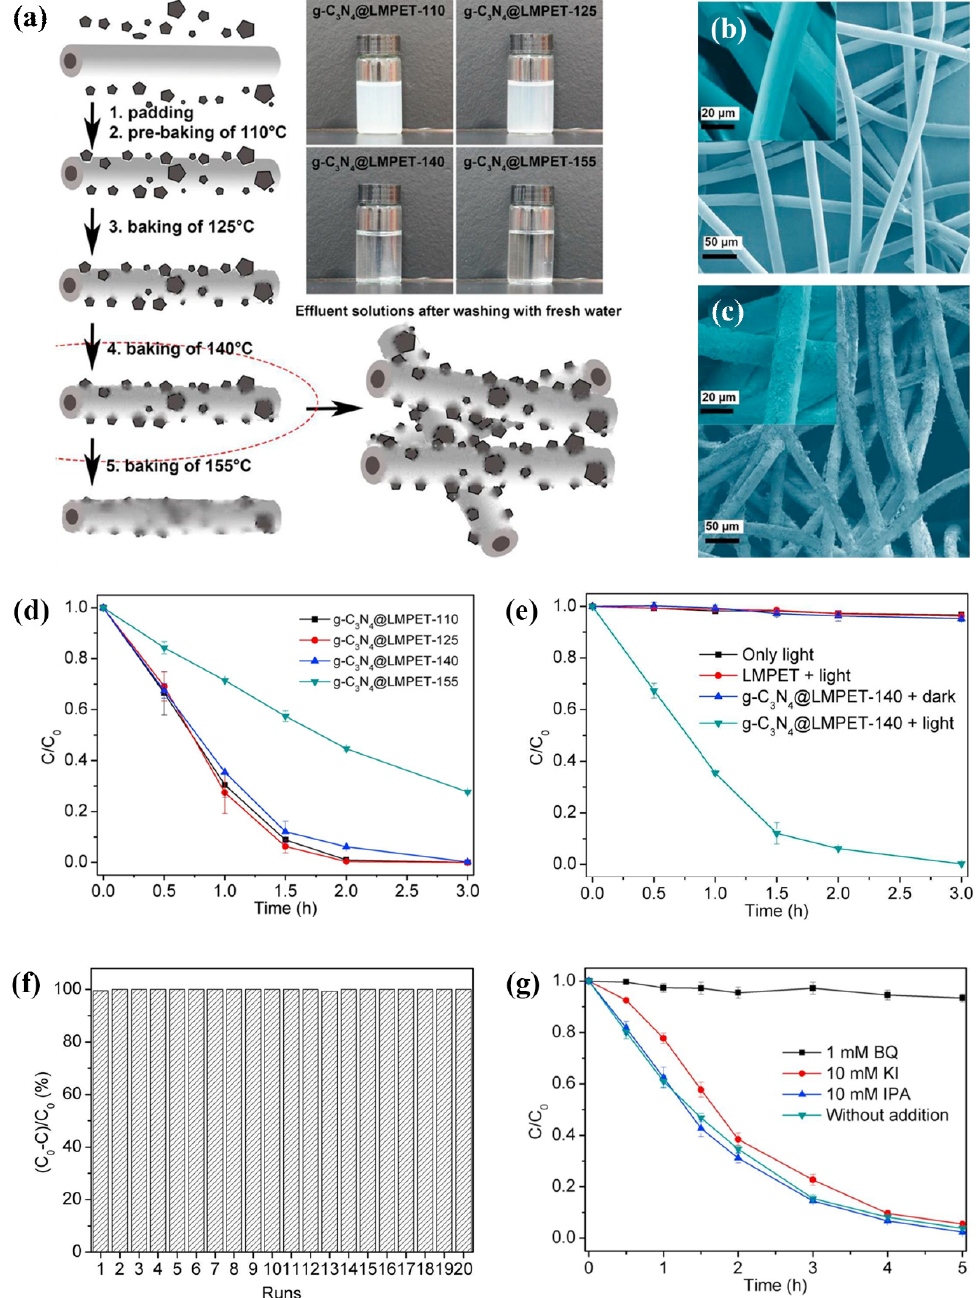
Figure 10. ( a ) Schematic presentation of the effect of curing (baking) temperature on fibre morphology and the corresponding effluent solutions after washing with fresh water. SEM images of ( b ) untreated LMPET sample and ( c ) g-C 3 N 4 @LMPET-140 sample cured at 140 ◦ C (b2). ( d ) Photocatalytic degradation of sulfadiazine (SDZ) by g-C 3 N 4 @LMPET-X samples cured at different temperatures (X corresponds to the curing temperature) under solar irradiation. ( e ) SDZ degradation by g-C 3 N 4 @LMPET-140 sample in different conditions. ( f ) Cyclic photocatalytic degradation of SDZ by g-C 3 N 4 @LMPET-140 under solar irradiation for 3 h. ( g ) Effect of trapping agent on the photocatalytic degradation of SDZ under solar irradiation. Reprinted with permission from [51]. Copyright 2018, Elsevier.